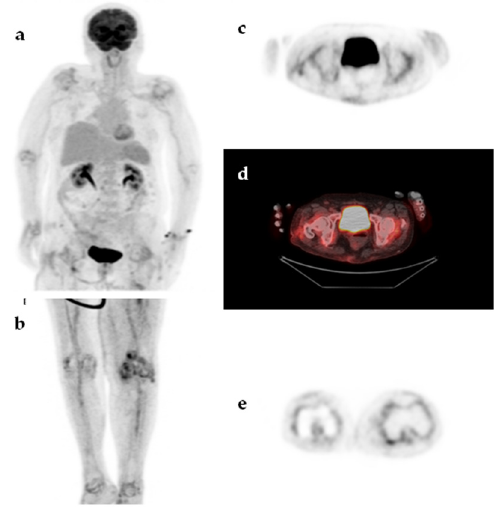
Figure 6. An 85-year-old woman presented with a 2-month fever. The patient had a history of total left knee arthroplasty with no signs of loosening or infection. MIP 18 F-FDG-PET image ( a , b ), transaxial 18 F-FDG-PET and 18 F-FDG-PET / CT images at the level of hips ( c , d ) and transaxial 18 F-FDG-PET image at the level of knees ( e ) demonstrated diffuse, symmetric, moderately increased 18 F-FDG uptake, in the large peripheral joints (shoulders, hips, knees) accompanied by increased 18 F-FDG uptake along the medium-sized arteries (axillary, humeral, femoral, and tibial arteries). The findings were compatible with polymyalgia rheumatica and the fever resolved upon treatment with corticosteroids.